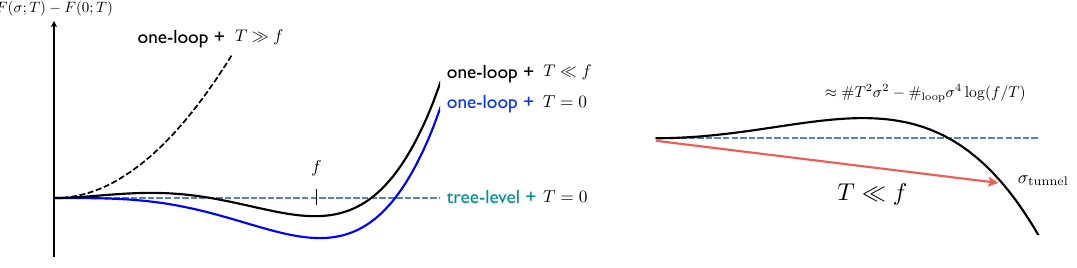
Figure 1 . On the left, free energy along (cid:27) for di(cid:11)erent values of the temperature. For T (cid:29) f the origin is the only minimum so that the symmetry is unbroken. At lower temperature a new minimum develops separated by a barrier of size proportional to T . The Universe is trapped in the false vacuum up to low temperatures where the relevant region for tunneling is well described by temperature dependent quartic potential (right